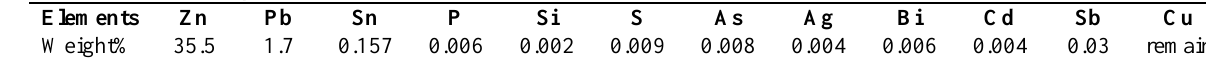
Tool Material Composition (Brass).